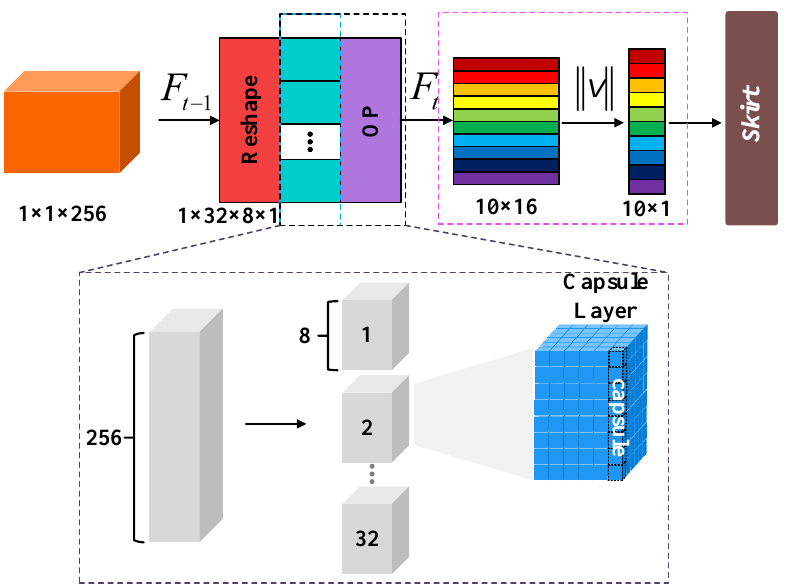
Figure 2. Overview of the traditional capsule network, where F t − 1 is input feature, and F t is output vector. It is used for spatial structure